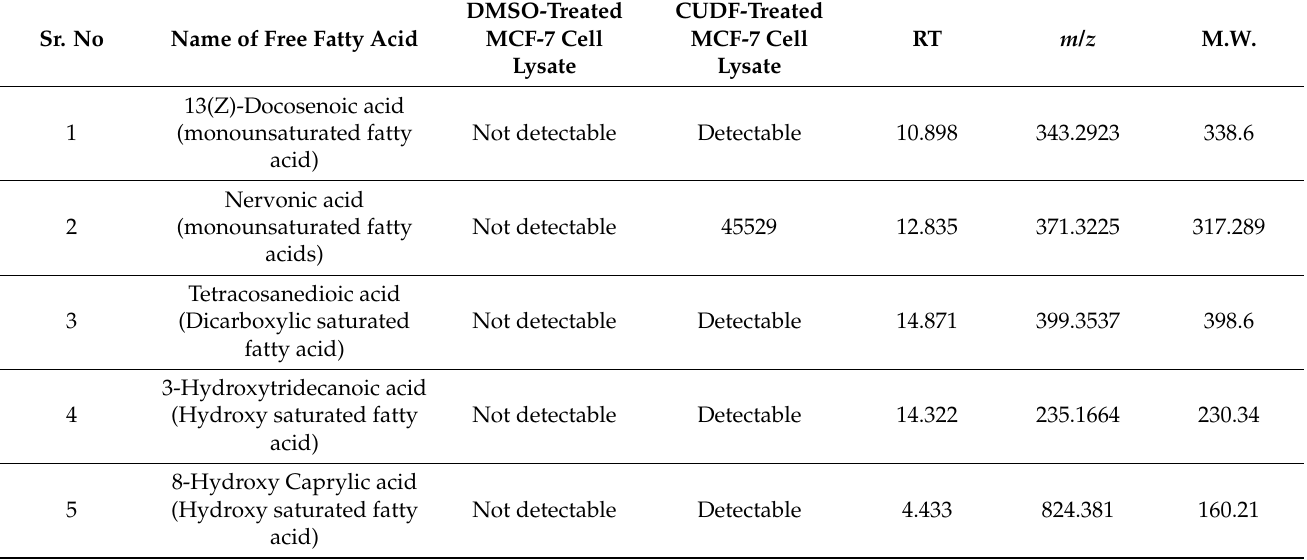
Table 1. A list of intracellular free fatty acid metabolites in DMSO- and CUDF-treated MCF-7 breast cancer cells. LC-HRMS spectra were obtained in positive ion